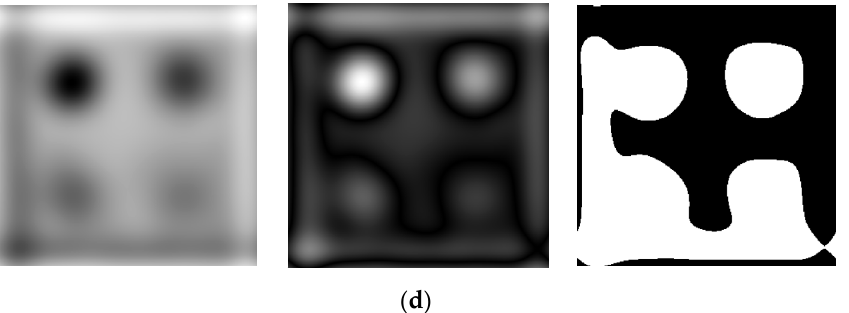
Figure 17. Comparison of a 2D-CWT analysis with different scale factors of ( a ) a = 1, ( b ) a = 5, ( c ) a = 15, and ( d ) a = 20, showing the influence of lowering the frequency. The input thermal image is at the early cooling stage ( t = 7.5